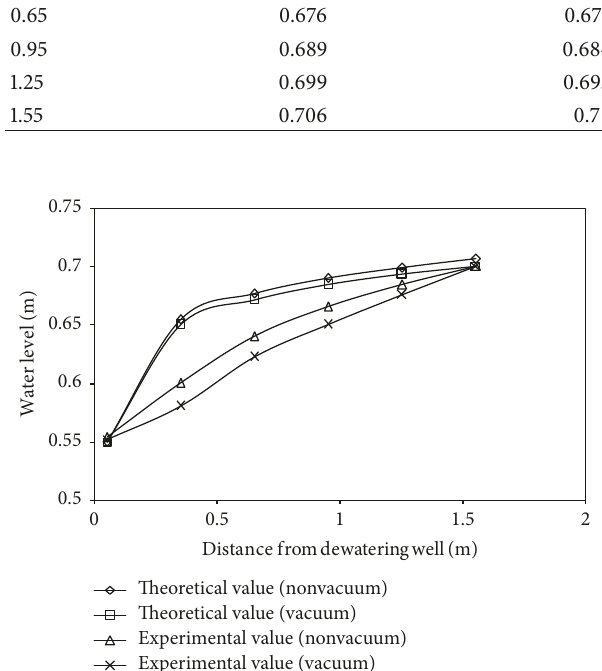
Figure 8: Water level in constant waterhead